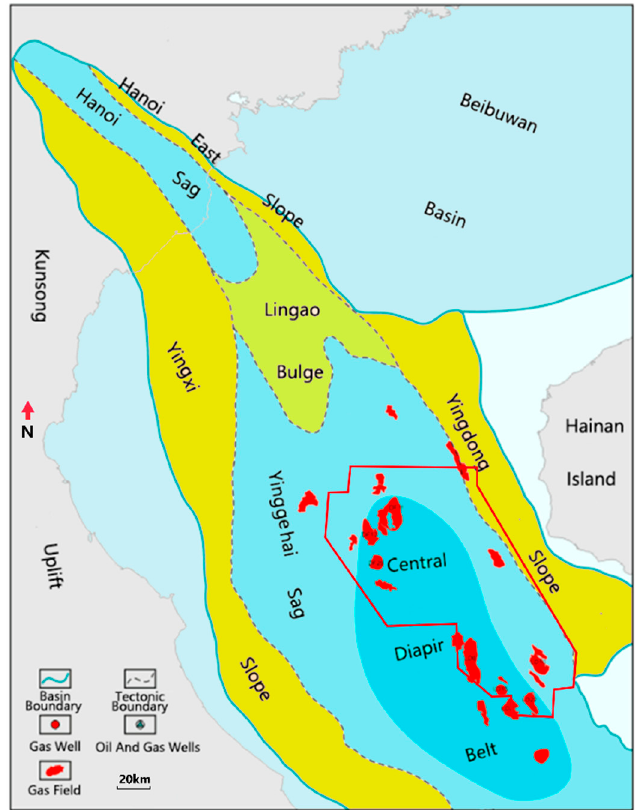
Figure 1. Tectonic map of the Yinggehai Basin, China, showing the location of the study area within the red lines.